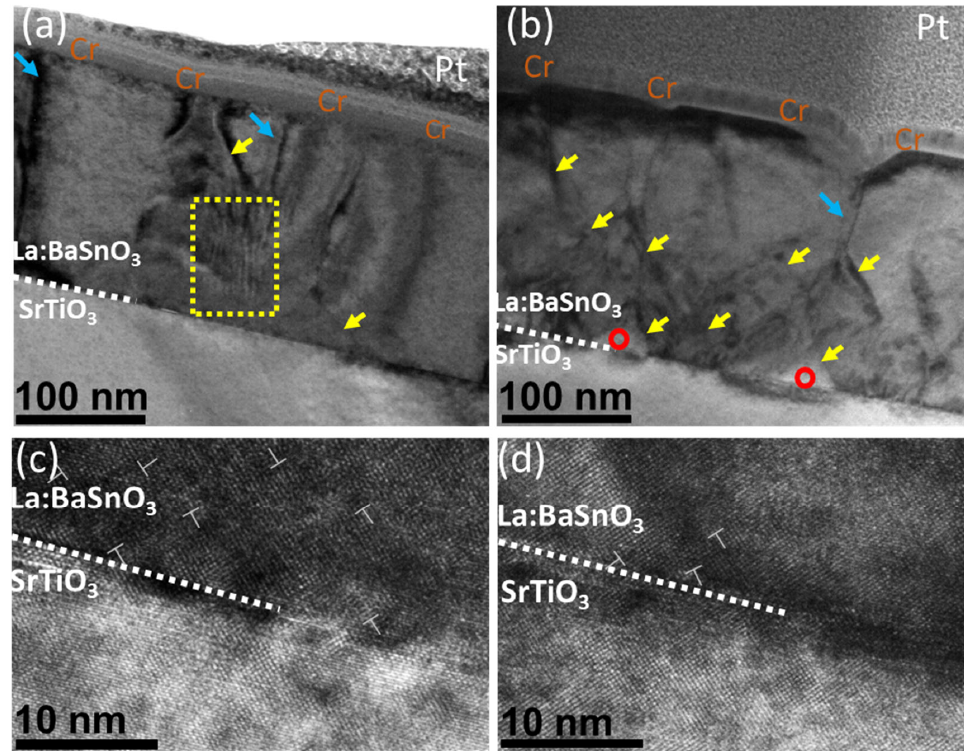
Figure 4. ( a ) Deposited and ( b ) annealed cross-sectional HAADF-STEM image of a La:BaSnO 3 film grown on a SrTiO 3 substrate. Blue arrows mark grain boundaries. Yellow arrows show threading dislocations. Red circles mark voids in the film. Yellow box Plan-view HAADF-STEM images of the ( c ) deposited and ( d ) annealed La:BaSnO 3 films with two unique line defects (in the yellow boxes) and one edge dislocation (indicated by a dislocation symbol).